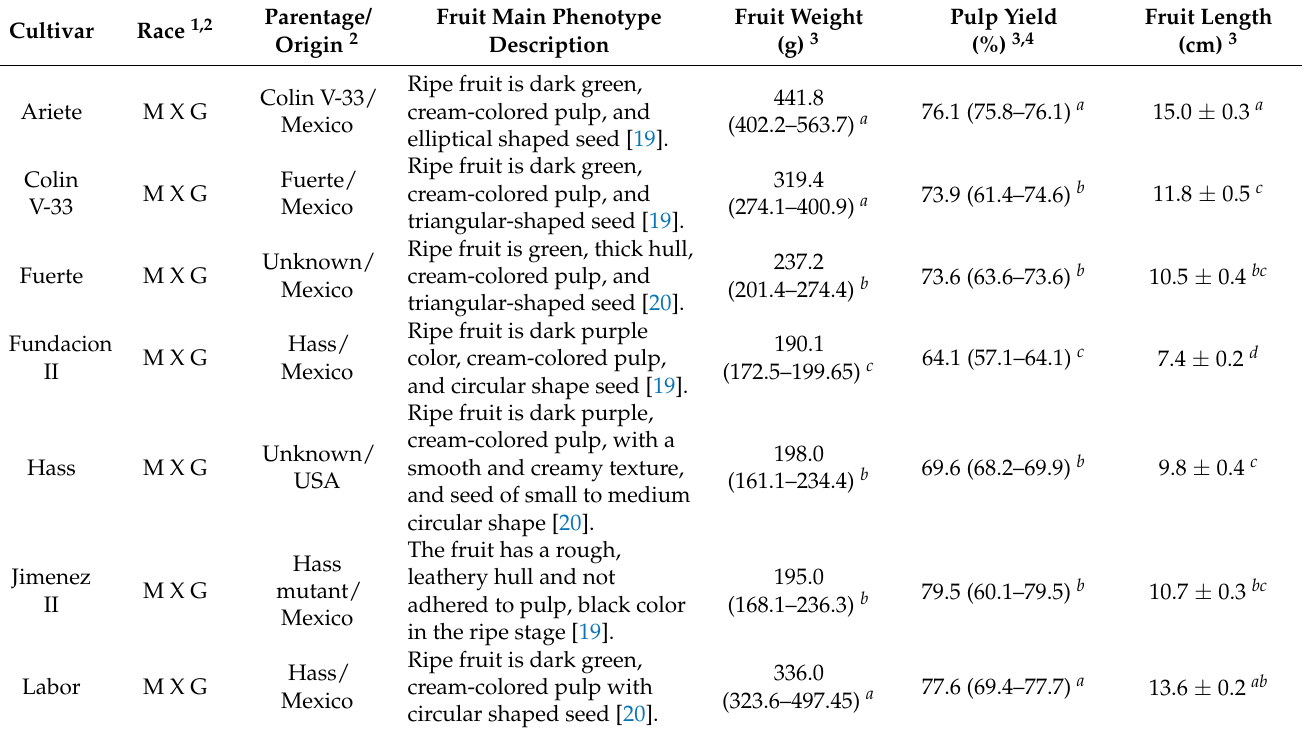
Table 1. Morphological traits and genotype relationships of avocado cultivar samples at commercial